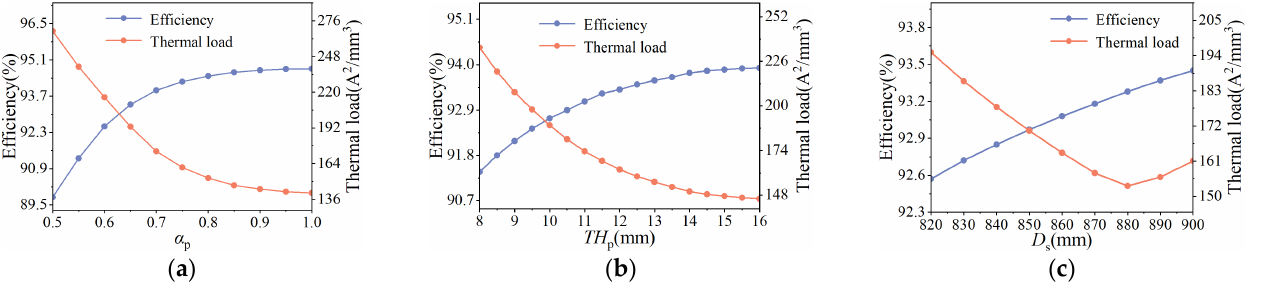
Figure 3. Influence curves of single factors on efficiency and thermal load. ( a ) Pole arc coefficient; ( b ) PM thickness; ( c ) stator outer diameter.